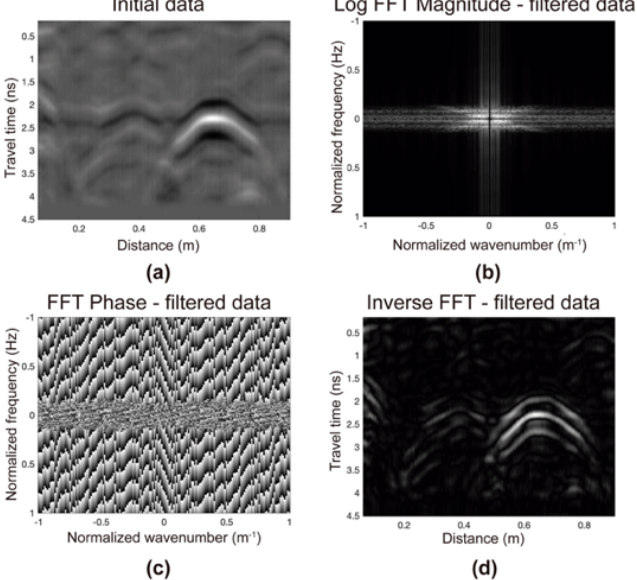
Figure 9. Results from the application of the filter in the spectral domain. ( a ) Input data in the space-time domain. ( b ) Magnitude spectrum of the filtered data. ( c ) Phase spectrum of the filtered data. ( d ) Resulting data CRN filtered in the space-time